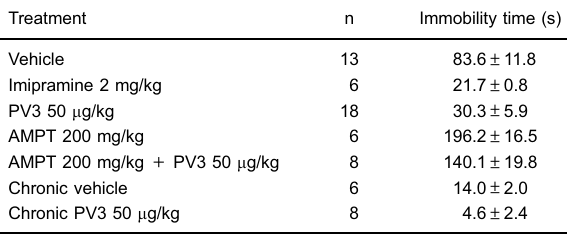
Table 4. Summary of the parameter analyzed in the forced swim